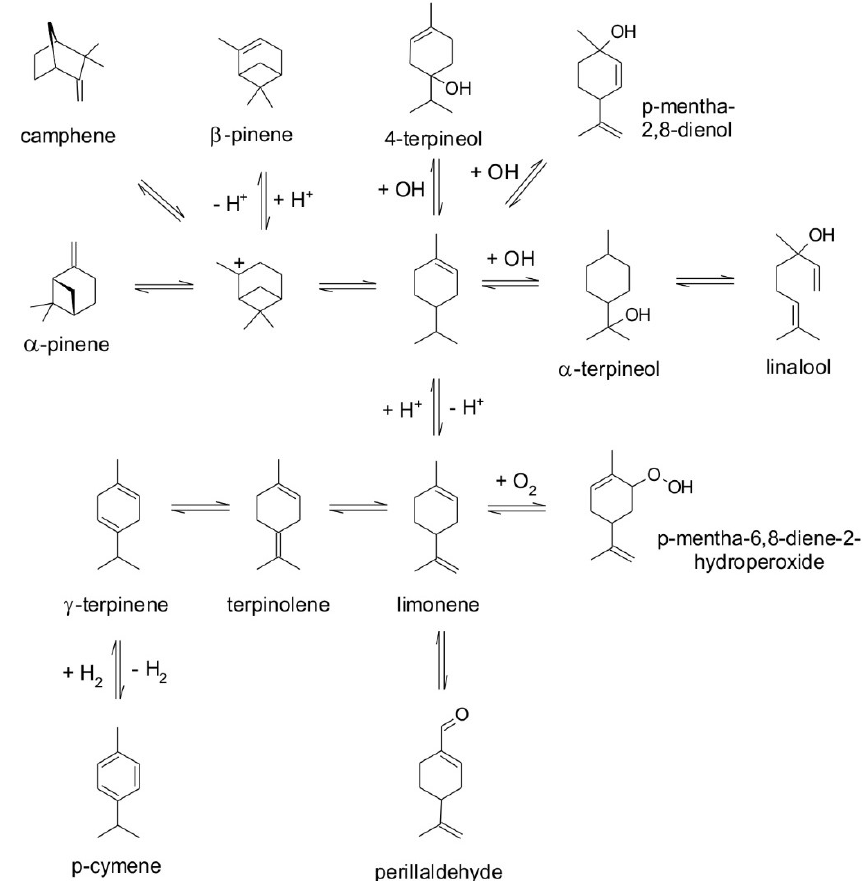
Figure 3. Putative chemical pathways observed in pasteurized orange juice during glow discharge plasma plasma treatment.